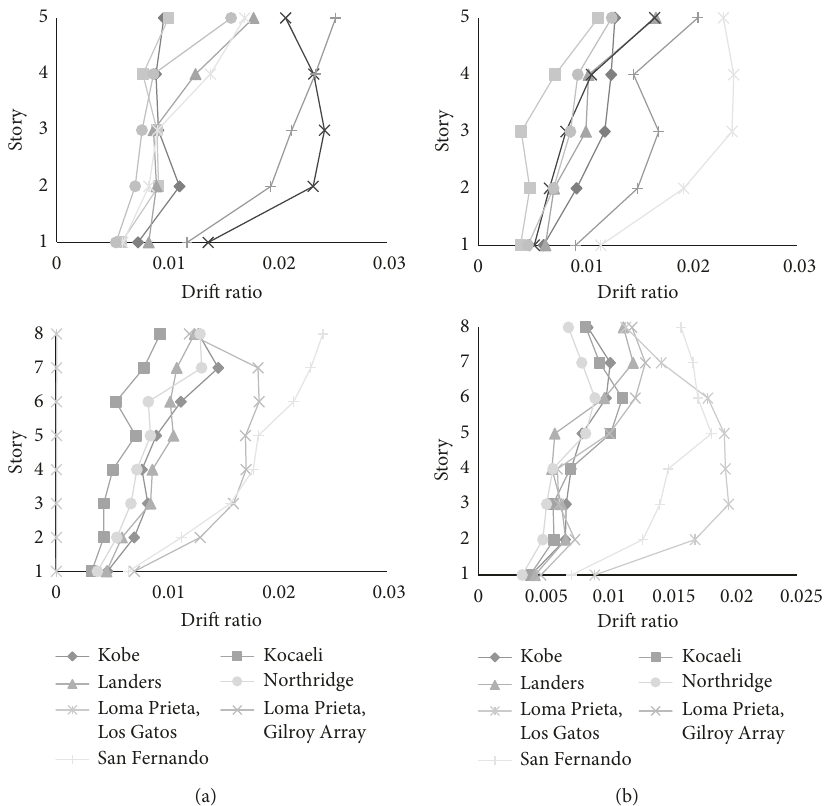
Figure 10: Maximum drift ratio variations of 5- and 8-story frames under near-field records. (a) Soil type II and (b) soil type III. Table 7: Average of maximum drift ratio under near-field records. Story